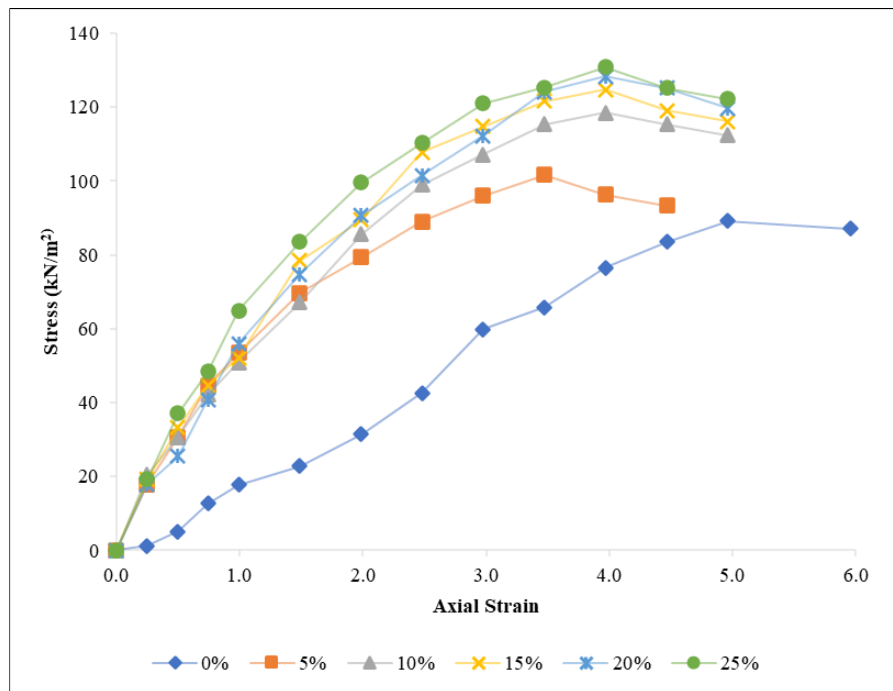
Figure 8. Stress – strain of soil – CHA mixture. Figure 8. Stress–strain of soil–CHA mixture.